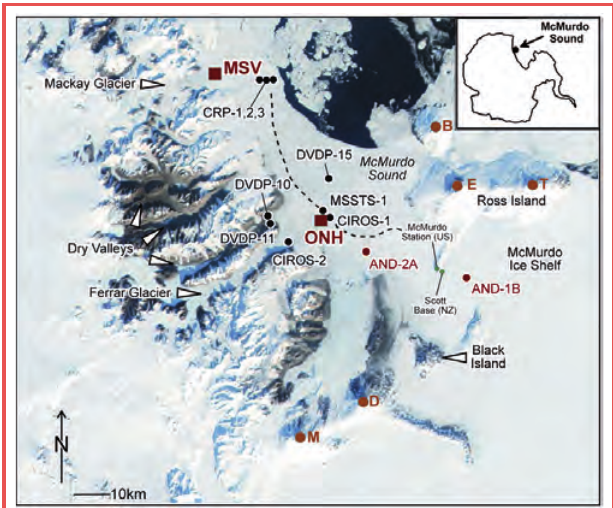
Figure 1. Location of key geographical features in southern McMurdo Sound, plus inset of Antarctica. The volcanic centers of Erebus (E), Terror (T), Bird (B), Discovery (D), and Morning (M) are annotated. The location of the two completed ANDRILL drill holes, AND-1B (McMurdo Ice Shelf), and AND-2A (Southern McMurdo Sound Project) are shown. The dashed line indicates the approximate margin of multiyear sea ice. Regions targeted for possible future drilling from sea-ice platforms include Offshore New Harbor (ONH) and Mackay Sea Valley (MSV). Also shown are the locations of previous stratigraphic drill holes (DVDP, CIROS, MSSTS, and CRP). (Modified after ANDRILL International Science Proposal, 2003; NASA MODIS image I.D.: